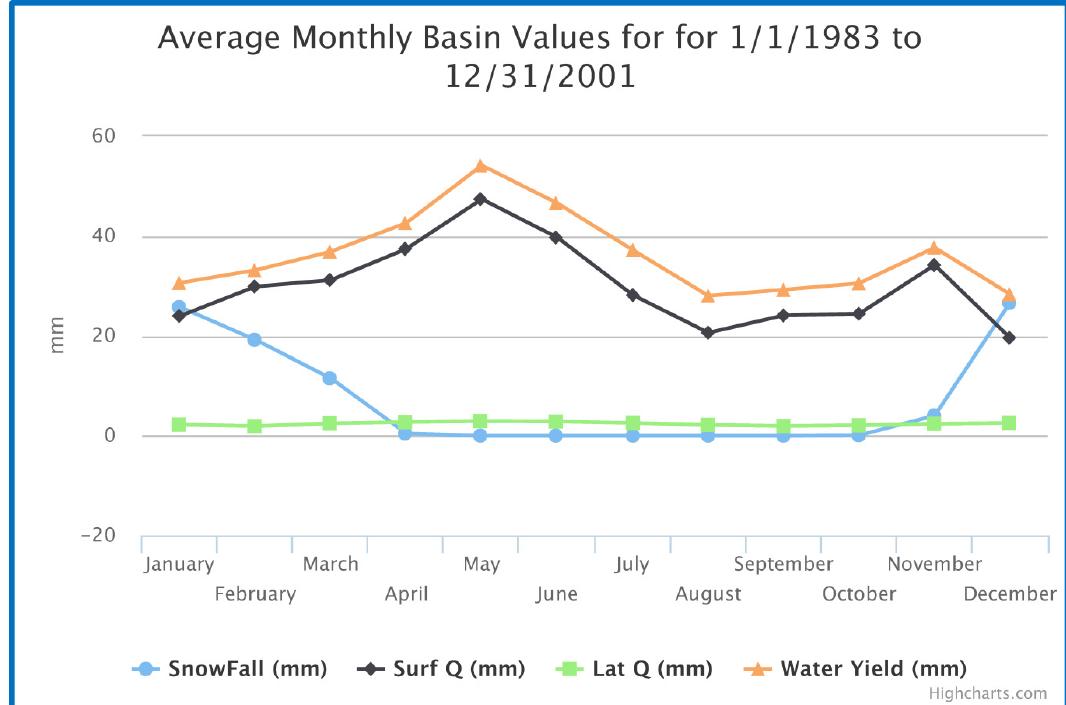
Figure 11. Average monthly basin values for snowfall, surface runoff, lateral flow and water yield for each month for the Illinois River Basin.